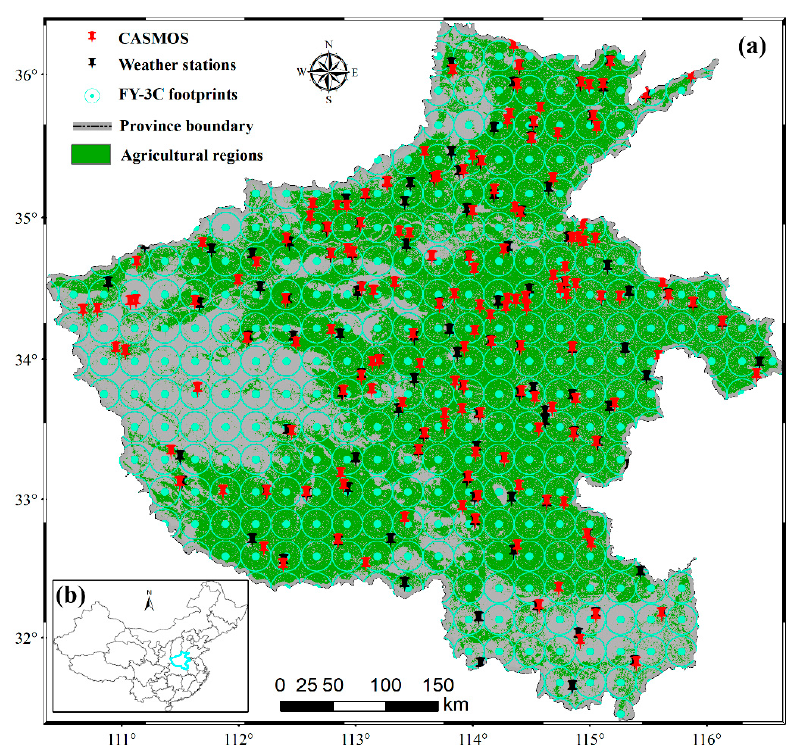
Figure 1. ( a ) The agricultural regions, Chinese Automatic Soil Moisture Observation Stations (CASMOS), the weather stations, and the footprints of Fengyun-3C (FY-3C) located in Henan province; ( b ) The location of Henan province in China.